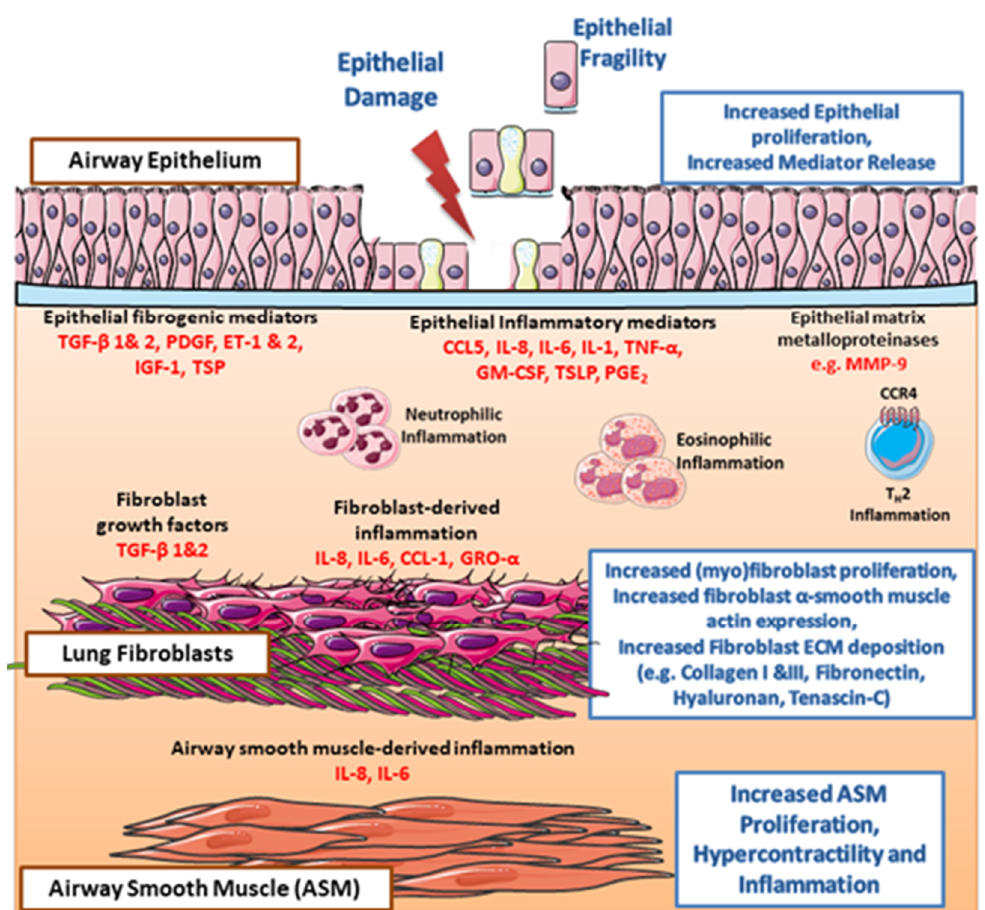
Figure 3. Epithelial-fibroblast interaction in the asthmatic epithelial-mesenchymal trophic unit. After damage to the airway epithelium, as a result of the exposure to allergens in asthmatic airways, the airway epithelium releases fibrogenic factors such as transforming growth factor (TGF)- β 1&2, platelet-derived growth factor (PDGF), endothelin (ET)-1&2, insulin-like growth factor (IGF)-1 and thrombospondin (TSP) that act on mesenchymal cells to induce increased cellular proliferation and ECM deposition (e.g., collagen 1 & III, fibronectin, hyaluronan, tenascin-C). The epithelium is also a source of a variety of inflammatory mediators including chemokine (C-C motif) ligand 5 (CCL5), interleukin (IL)-1, IL-8, IL-6, tumor necrosis factor (TNF)- α , granulocyte monocyte colony-stimulating factor (GM-CSF) and thymic stromal lymphopoietin (TSLP). These cytokines act on mesenchymal cells to cause the release of inflammatory mediators such as IL-8, IL-6, CCL1 and growth-regulated oncogene (GRO)- α . This inflammatory milieu stimulates neutrophilic, eosinophilic, and T H 2 inflammation in di ff erent subtypes of asthma. The release of cytokines such as prostaglandin (PG)E 2 and IL-1 also stimulates fibroblast ECM production and causes abnormal fibroblast ECM repair. Matrix metalloproteinases (MMP) such as MMP-9 are also released for the airway epithelium to stimulate mesenchymal cell proliferation and ECM production. In addition to this, mesenchymal cells produce growth factors such as TGF- β 1 / 2 that act on the airway epithelium to cause increased or decreased cell proliferation and remodeling in a feedback cycle that promotes airway remodeling and inflammation in the asthmatic